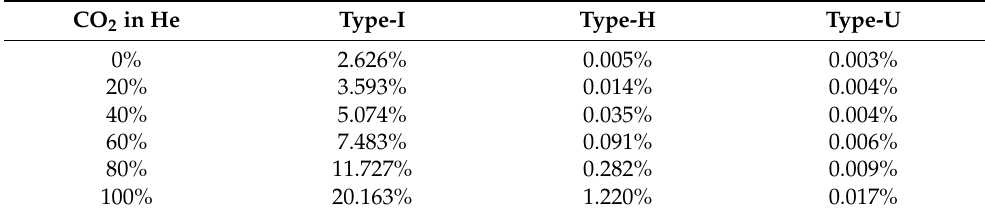
Simulation results: the normalized temperature change of the hot film under multiple